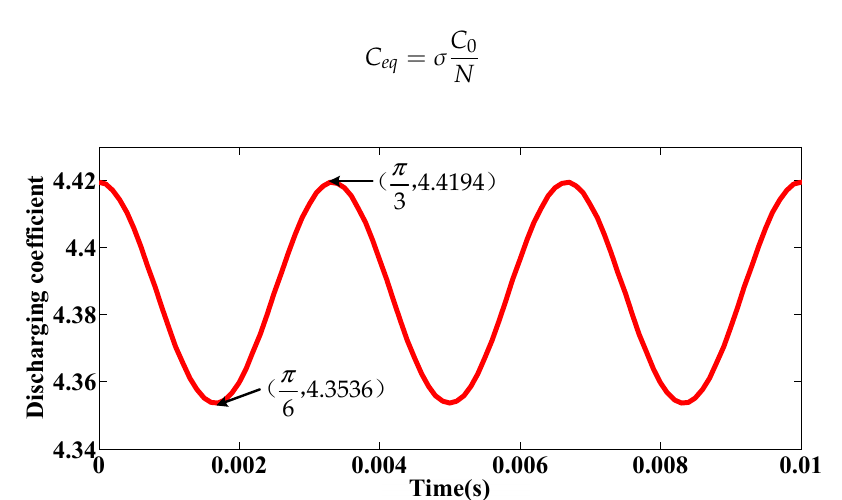
> Figure 3. Direct current pole-to-pole fault circuit diagram before blocking submodules